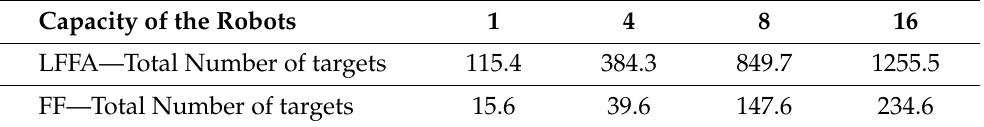
Table 8. Total number of targets when varying the capacity of the robots— Scenario 2